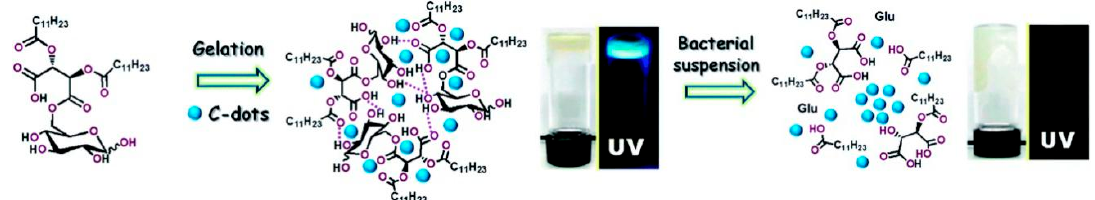
Figure 2. Hybrid CD–hydrogel composite for bacterial detection. Reproduced with permission from